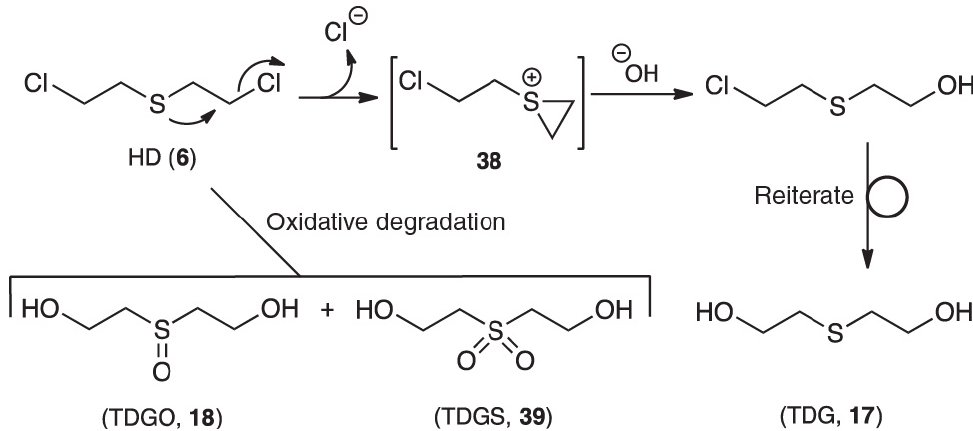
Figure 8: Mode of alkylation by the sulfur mustards (shown for HD) and their main degradation products from their ox- idative